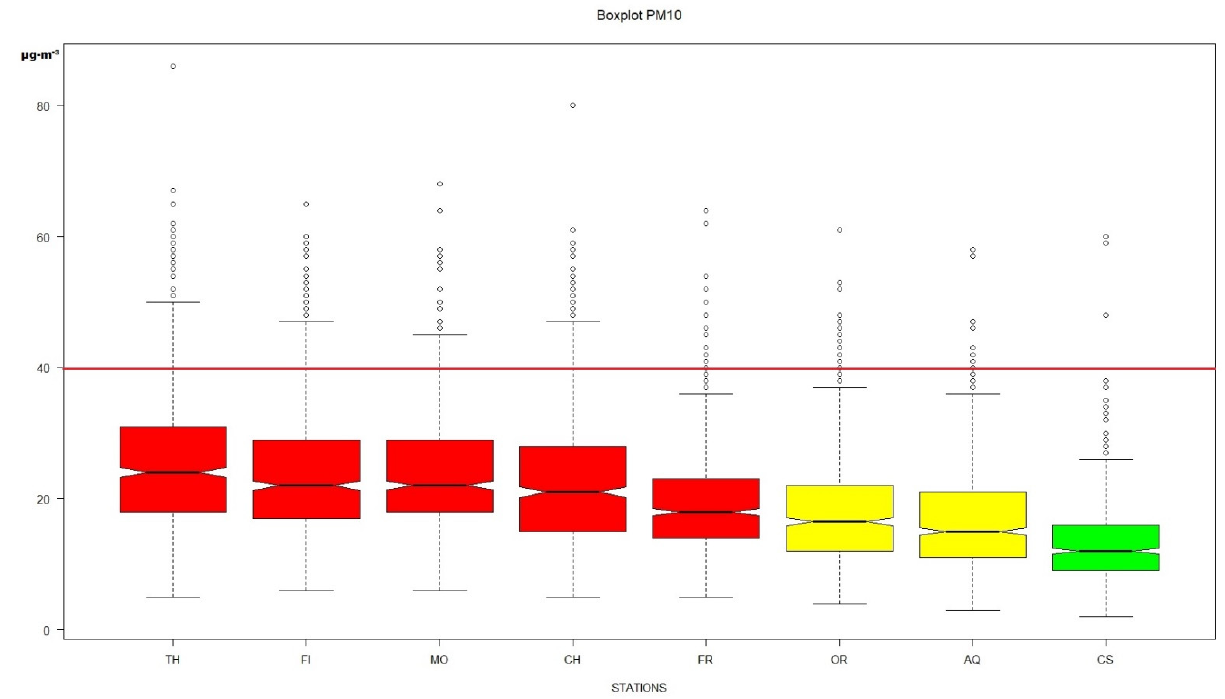
Figure 3. Boxplot of PM10 distributions in µg · m − 3 in the eight stations of the network, two-year period 2017–2018: in red are the stations in AGG, in yellow are those in MAXP, and in green is the station in MINP. The red line indicates the annual EU limit for PM10.